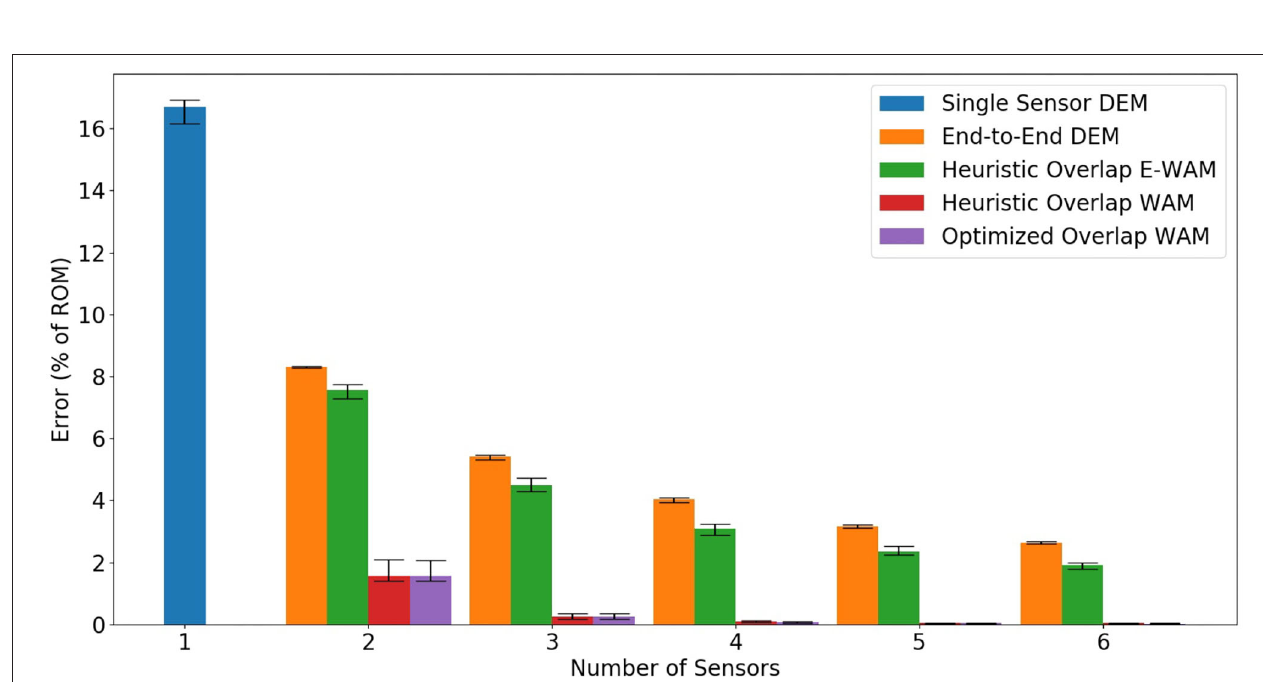
FIGURE 7 | This bar graph shows the median results for all of the simulated joints’ “Average % Error of ROM” (defined in Equation 12) of all the joint’s segments. Quartile bars are included to show the spread of the results.